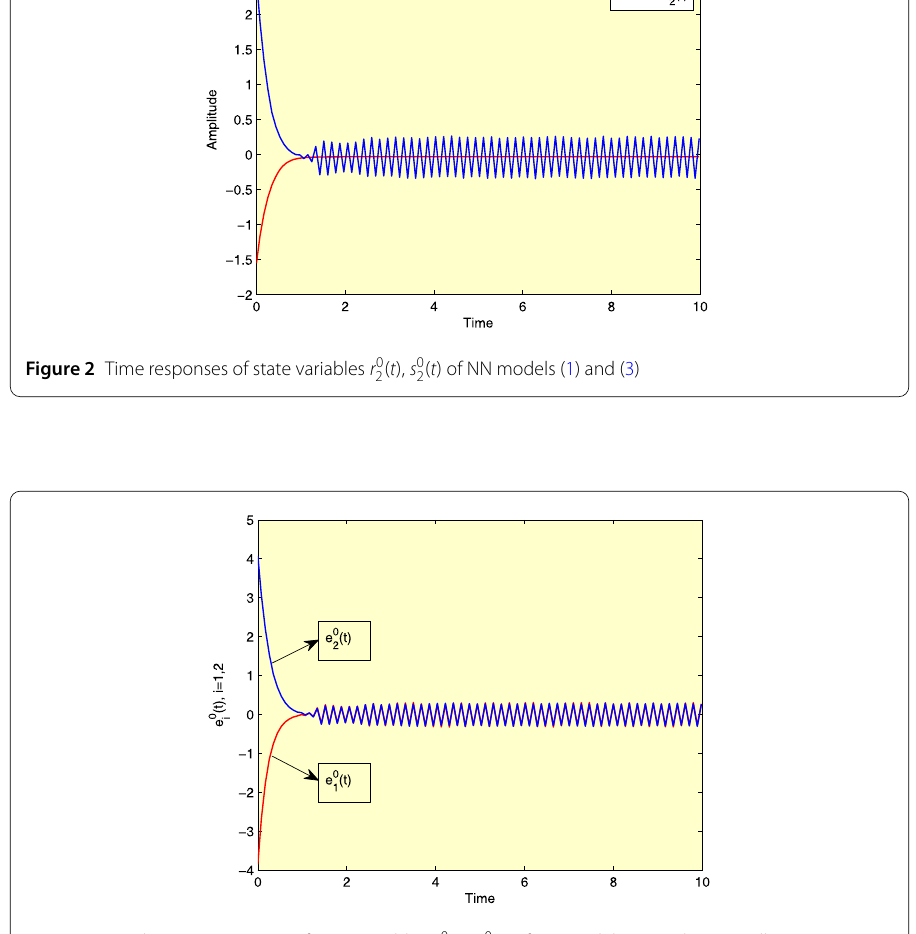
Figure 3 Synchronization curves of state variables e 0 1 ( t ), e 0 2 ( t ) of NN model (10) under controller